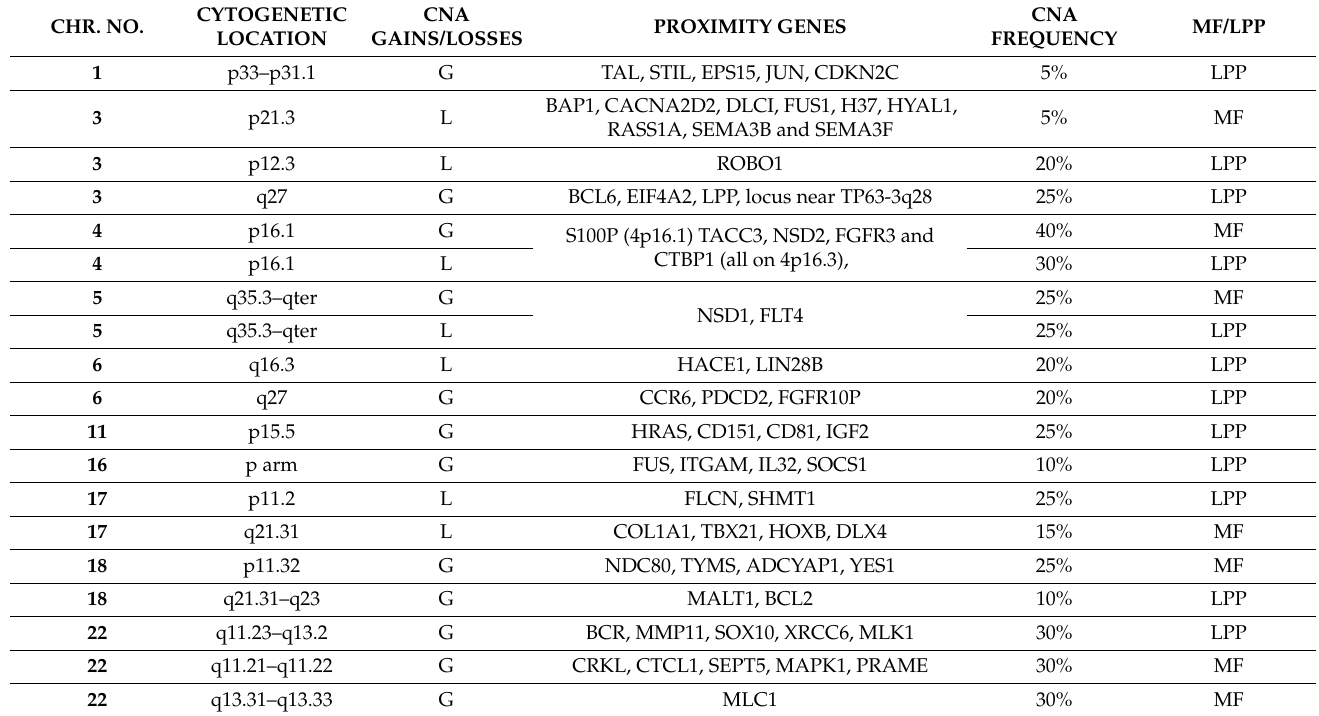
Table 3. Summary of CNA differences between MF and LPP.